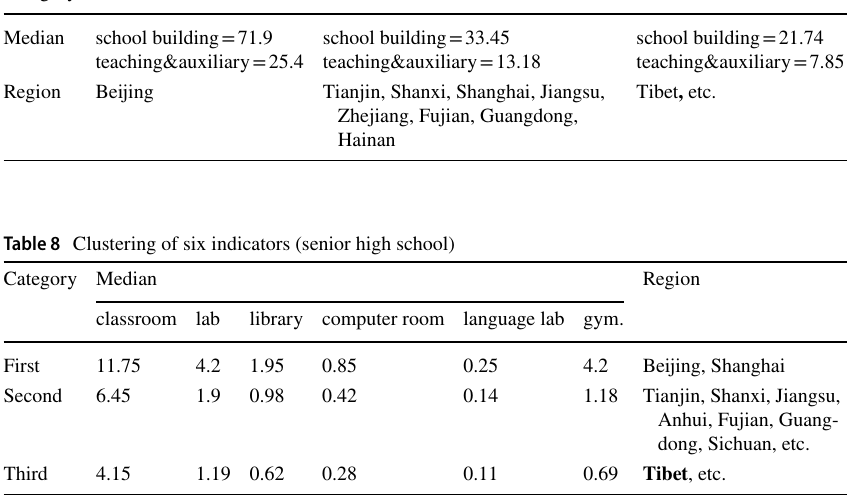
Table 7 Clustering of construction area of school building and teaching & auxiliary facilities (senior high school) Category First